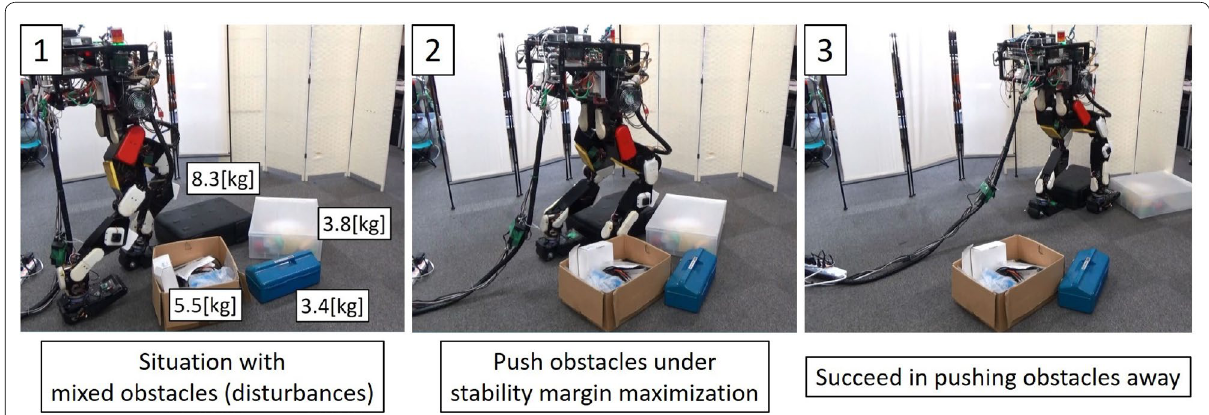
Fig. 16 Locomotion experiment with pushing obstacles